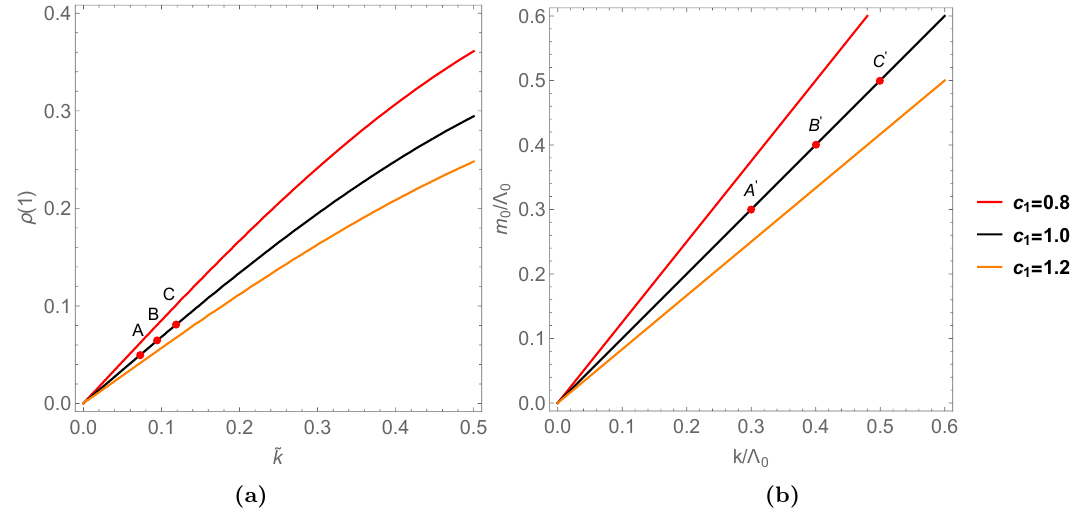
Figure 2. The numerical parameter space and the physical parameter space. The (cid:12)gure (a) shows solution lines with c 1 = 0 : 8 (red), 1 (black) and 1.2 (orange) in terms of numerical shooting param- eters. The corresponding solution lines in the physical parameter space are shown in (cid:12)gure